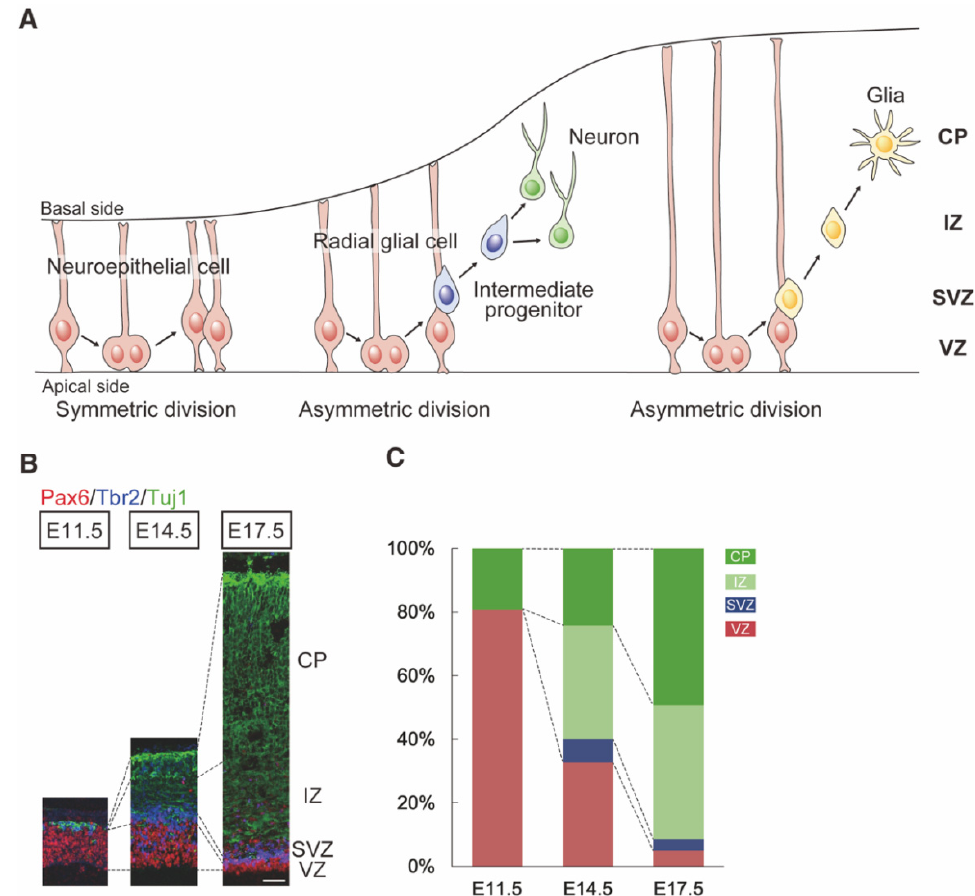
Figure 3. Neural stem cell (NSC) differentiation in the embryonic cortex. ( A ) Neuroepithelial cells undergo symmetrical cell division to increase the population of neural stem cells (NSCs, proliferation phase). When brain development progresses, neuroepithelial cells elongate their processes stretching from the apical surface of the ventricular zone (VZ) to the basal tip (basal endfoot) at the pia surface; these cells are now called radial glial (RG) cells. They undergo asymmetrical cell division and induce intermediate progenitor cells (IPCs), as well as neurons. Intermediate progenitors migrate to the subventricular zone and differentiate into neurons. Subsequently, these neurons migrate towards the basal side. After producing neurons, RG cells produce glia, i.e., astrocytes and oligodendrocytes. The graphical diagram has been redrawn from [80]. ( B ) Expression of Pax6, Tbr2, Tuj1 in the developing cortex at E11.5, E14.5, and E17.5: Pax6 (red), Tbr2 (blue), and Tuj1 (green). These proteins are expressed in the VZ, subventricular zone (SVZ), intermediate zone (IZ), and cortical plate (CP), respectively. Scale bar: 100 μ m. ( C ) The transition of the relative volume of brain subdivisions in the developing cortex. The Pax6-positive VZ area gradually narrowed during development.